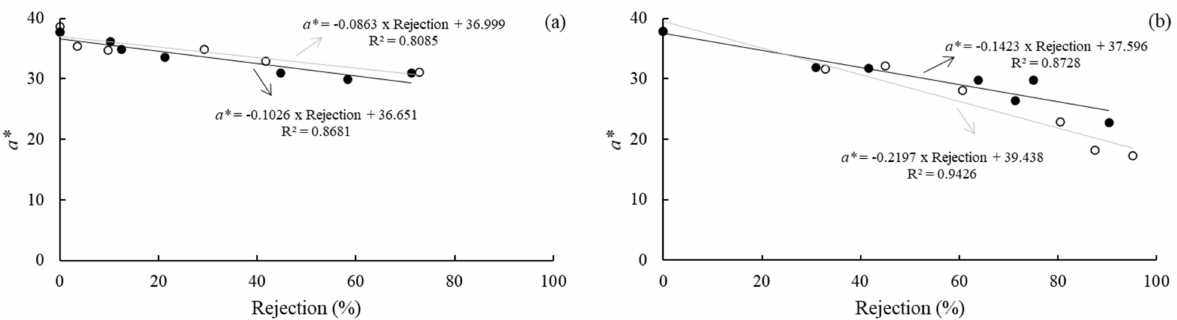
Figure 7. Relationship between the consumer rejection probability and a* chromatic parameter of the strawberry leather during storage at 22.5% RH ( a ) and 52.3% RH ( b ), with no illumination ( • ) and with illumination ( (cid:35)